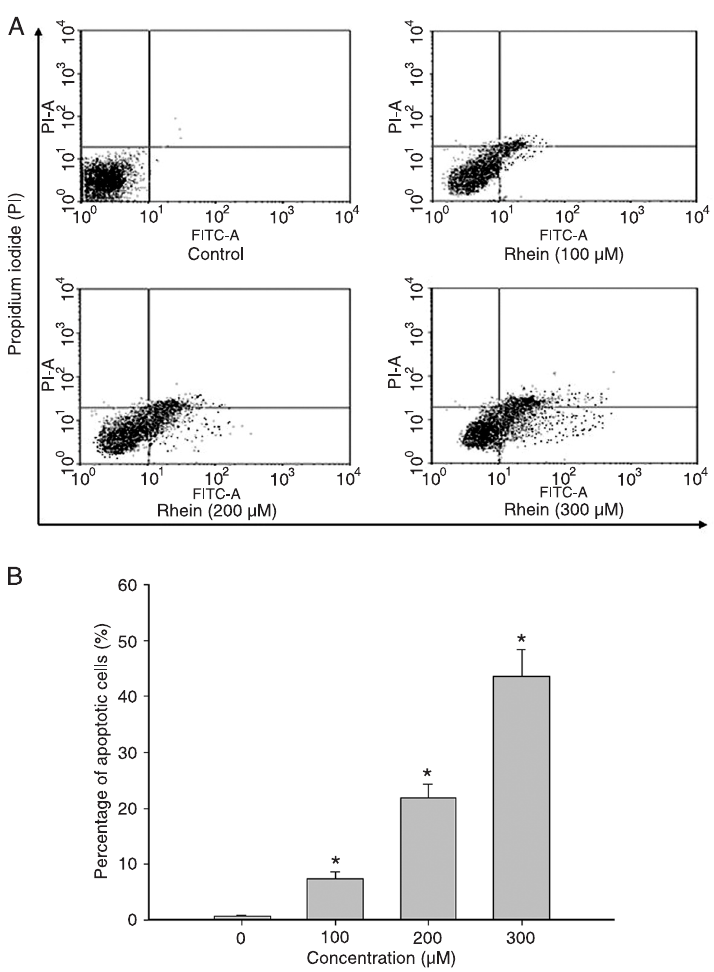
Figure 3. Rhein-induced apoptosis in SGC-7901 cells was determined by flow cytometry using the annexin FITC-PI staining method. The cells were treated with rhein (0, 100, 200, or 300 µM) for 48 h. The lower right quadrant indicates the percentage of early apoptotic cells (FITC-stained cells) and the upper right quad- rant indicates the percentage of late apoptotic cells (FITC-PI-stained cells) ( A ). The experiment was repeated three times and the percentage of apoptotic cells (means ± SEM) for each treatment group is shown in B . *P < 0.05 versus control group (0 µM) (one-way ANOVA followed by the Tukey post hoc